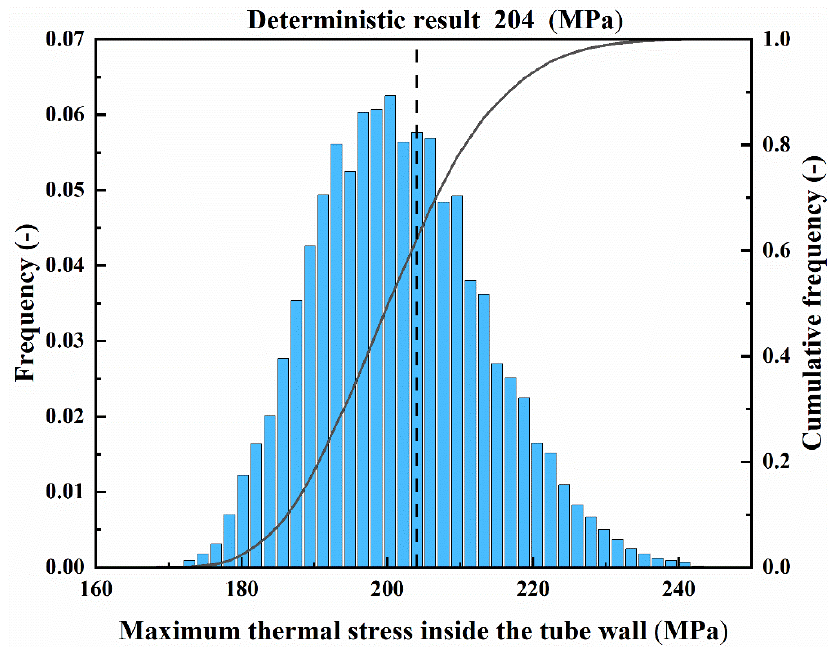
Figure 11. Probability distribution of the maximum thermal stress inside the tube wall under uncer- tainty.